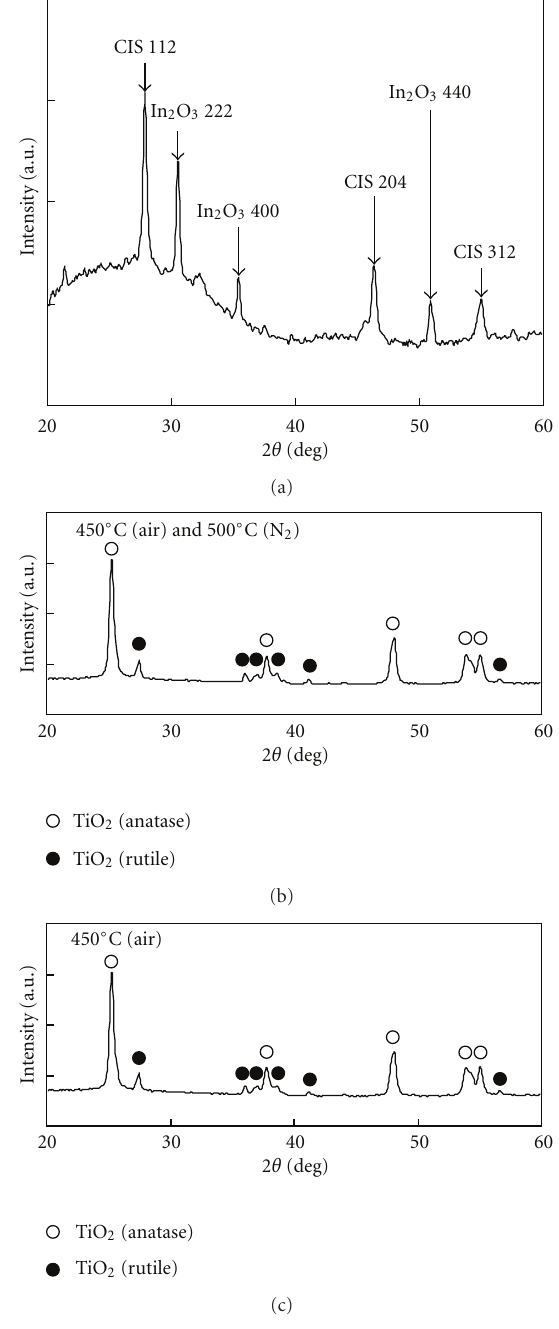
Figure 3: XRD pattern of (a) CIS thin film and (b) TiO 2 thin film annealed at 450 ◦ C for 30 minutes in air and 500 ◦ C for 30 minutes in N 2 / H 2 atmosphere and (c) TiO 2 thin film annealed at 450 ◦ C for 30 minutes in air.